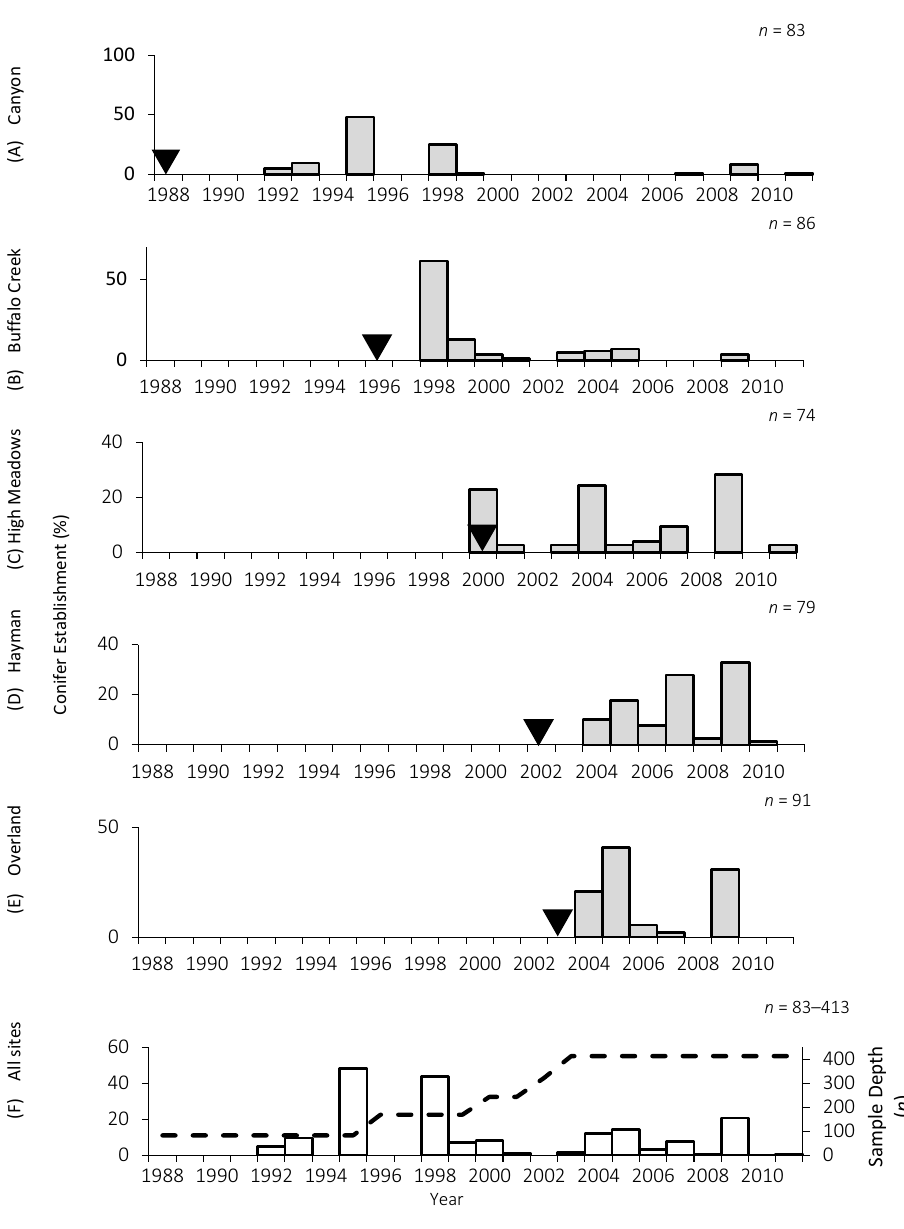
Figure 3. Percent establishment by ponderosa pine and Douglas-fir combined at each of the five sites ( A – E ) and for the full dataset of all five sites ( F ). The black triangles in parts ( A – E ) indicate the year of fire. The dashed line in part ( F ) indicates sample depth through